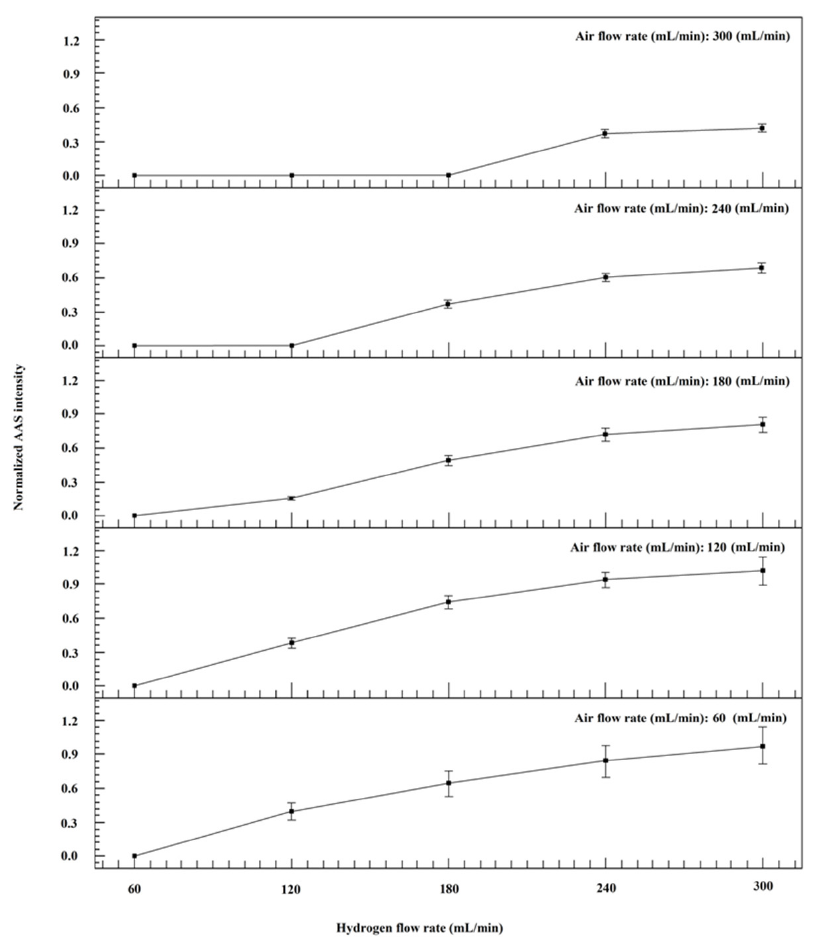
Figure 3. Optimization of air flow rate during the dehydration and pre-vaporization procedures. Herein, the CRM of peanut powder (GBW(E)100718) was measured by the ETV-AAS using different air flow rates. Other experimental conditions were performed as shown in Table 1. The Cd intensity under 250 mL/min air flow rate was set as 1, and others were normalized with it. Table 1. Cd presence in chocolate samples measured by the ETV-AAS method ( n = 3).